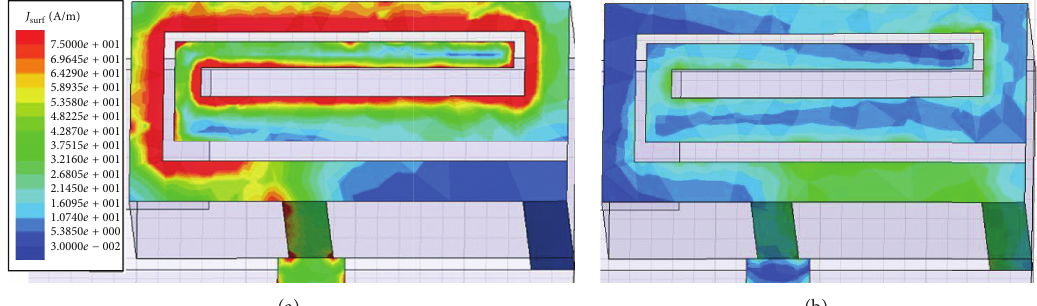
Figure 10: Current distributions at (a) 2.4 GHz and (b) 5.5